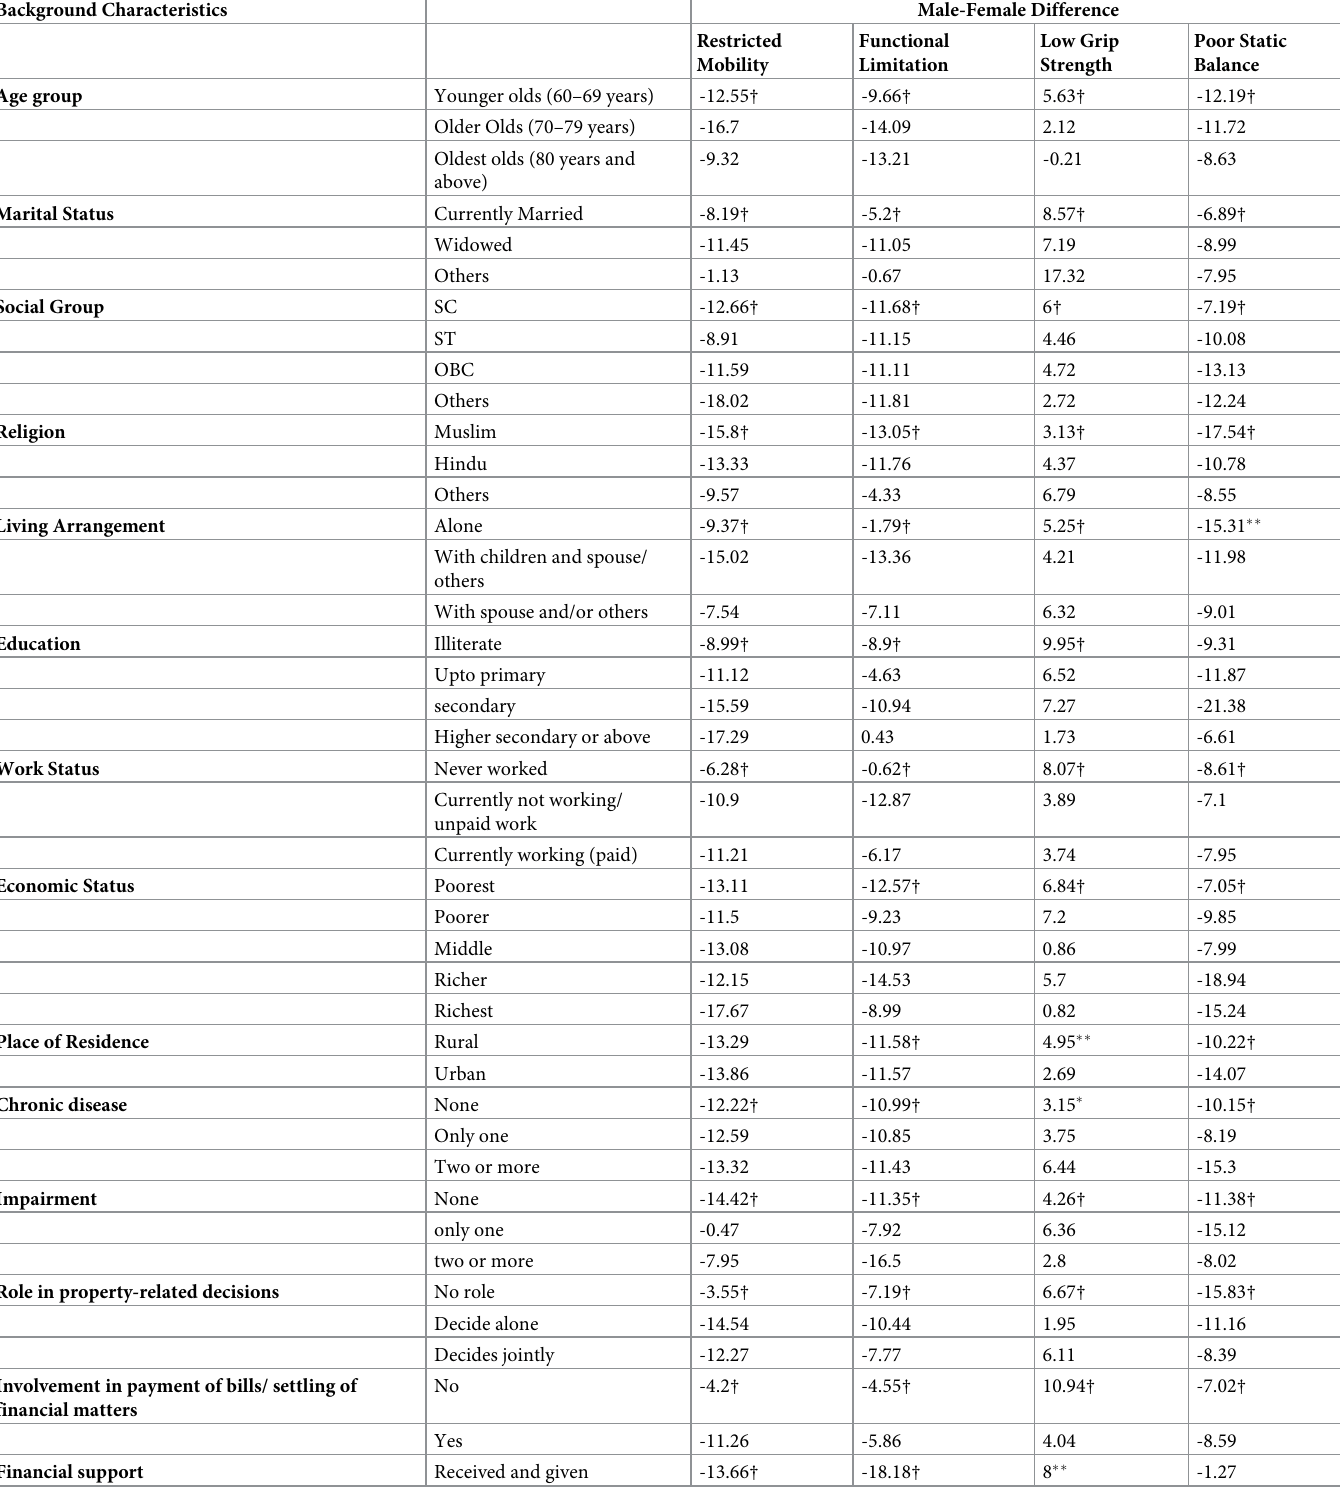
Table 3. Gender differentials in the prevalence of poor health outcomes (subjective and objective) by background characteristics. Background